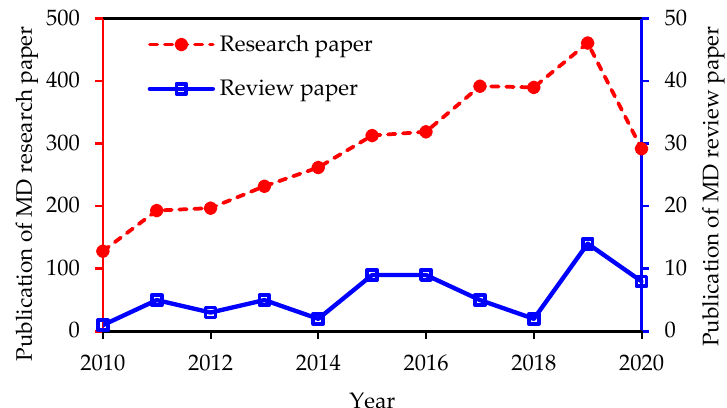
Figure 1. Number of publications on MD research papers and review papers from 2010 to August 2020 (obtained from Google Scholar).